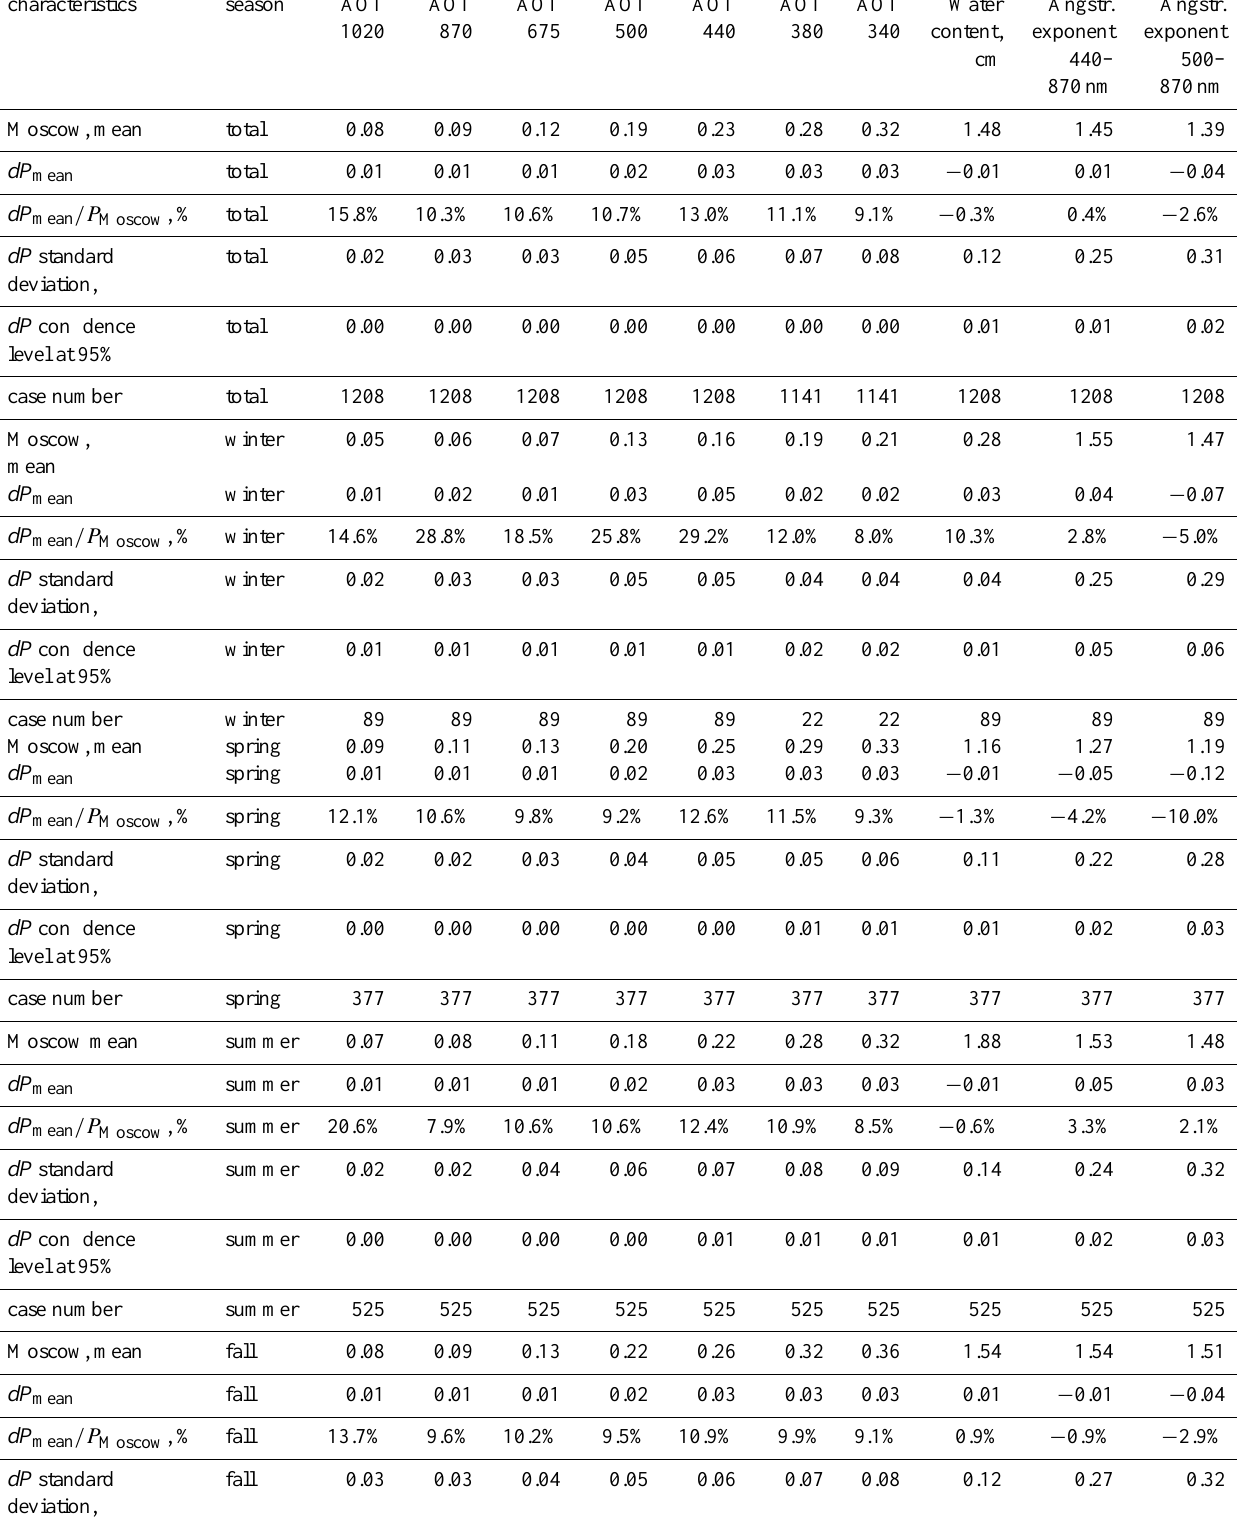
Table 1. Mean values of aerosol parameters in Moscow and the statistics of the differences dP = P Moscow − P Zvenigorod between Moscow and Zvenigorod main aerosol parameters in different seasons. 2006–2009 period. Dataset 1.